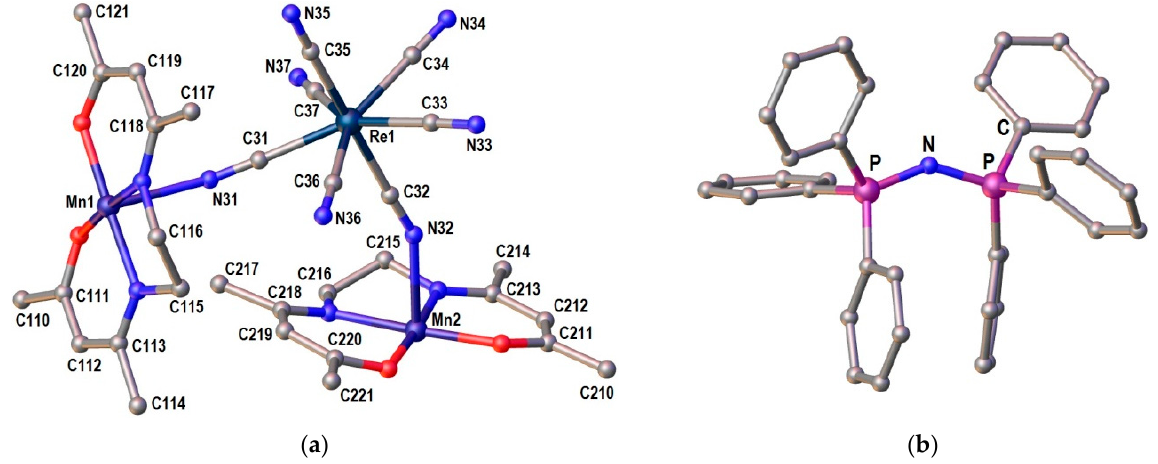
Figure 18. ( a ) Independent part, [{Mn( acacen )] 2 [Re(CN) 7 ] − , of 15 with the atom-numbering scheme of unique atoms; ( b ) PPN + molecular structure. Triclinic, P 1; a , b , c (Å): 10.7016(5), 10.8268(5), 16.2004(7); α , β , γ (°): 102.662(1), 93.607(1), 90.207(1); V = 1827.47(14) (Å 3 ), Z = 1, T = 298 K [56]. Each [Re IV (CN) 7 ] 3 − metalloligand is linked to four [Mn( acacen )] + cations by means of four cyanides with corresponding distances: Mn1–N31 apical of 2.384(3) Å and Mn2–N32 equat of 2.299(5) Å. The Mn–N ≡ C bond angles are 154.5(5) and 155.2(3) ◦ for apical and equatorial a bent mode [56], although this bending is substantially less than the 144.2 ◦ and 145.1 ◦ observed in 12 and 13 ,